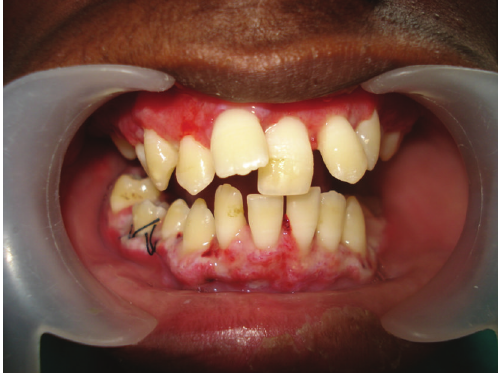
Figure 3: Postoperative intraoral view after 2 weeks.